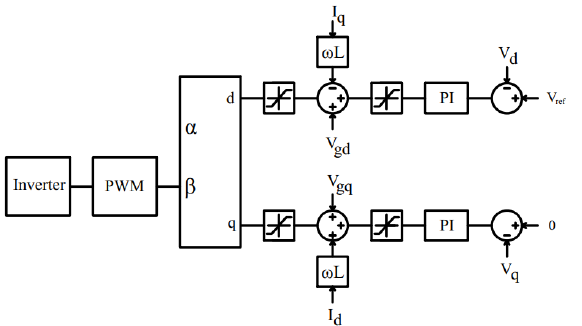
Figure 16. The block diagram of the inverter controller standalone operation mode.